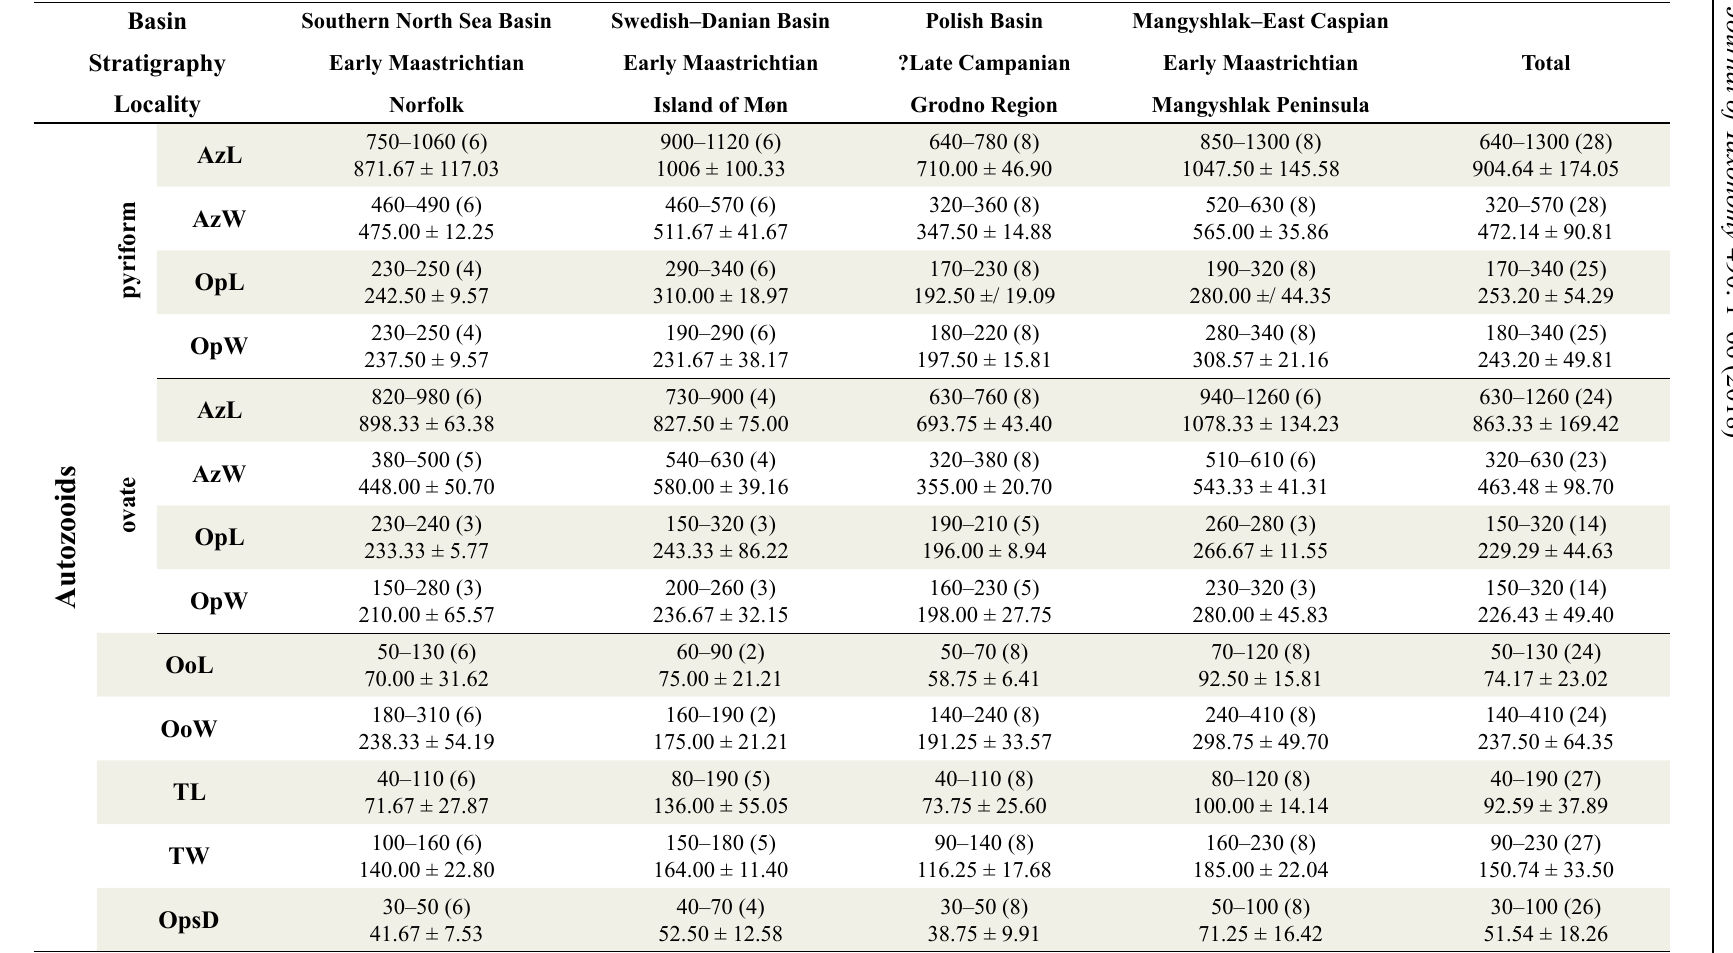
Table 11 (continued on next page). Summary of measurements of Rhagasostoma mimosa (Brydone, 1930). For each parameter the range is given with the number of measurements in brackets. The arithmetic mean is given ± standard deviation. All measurements in